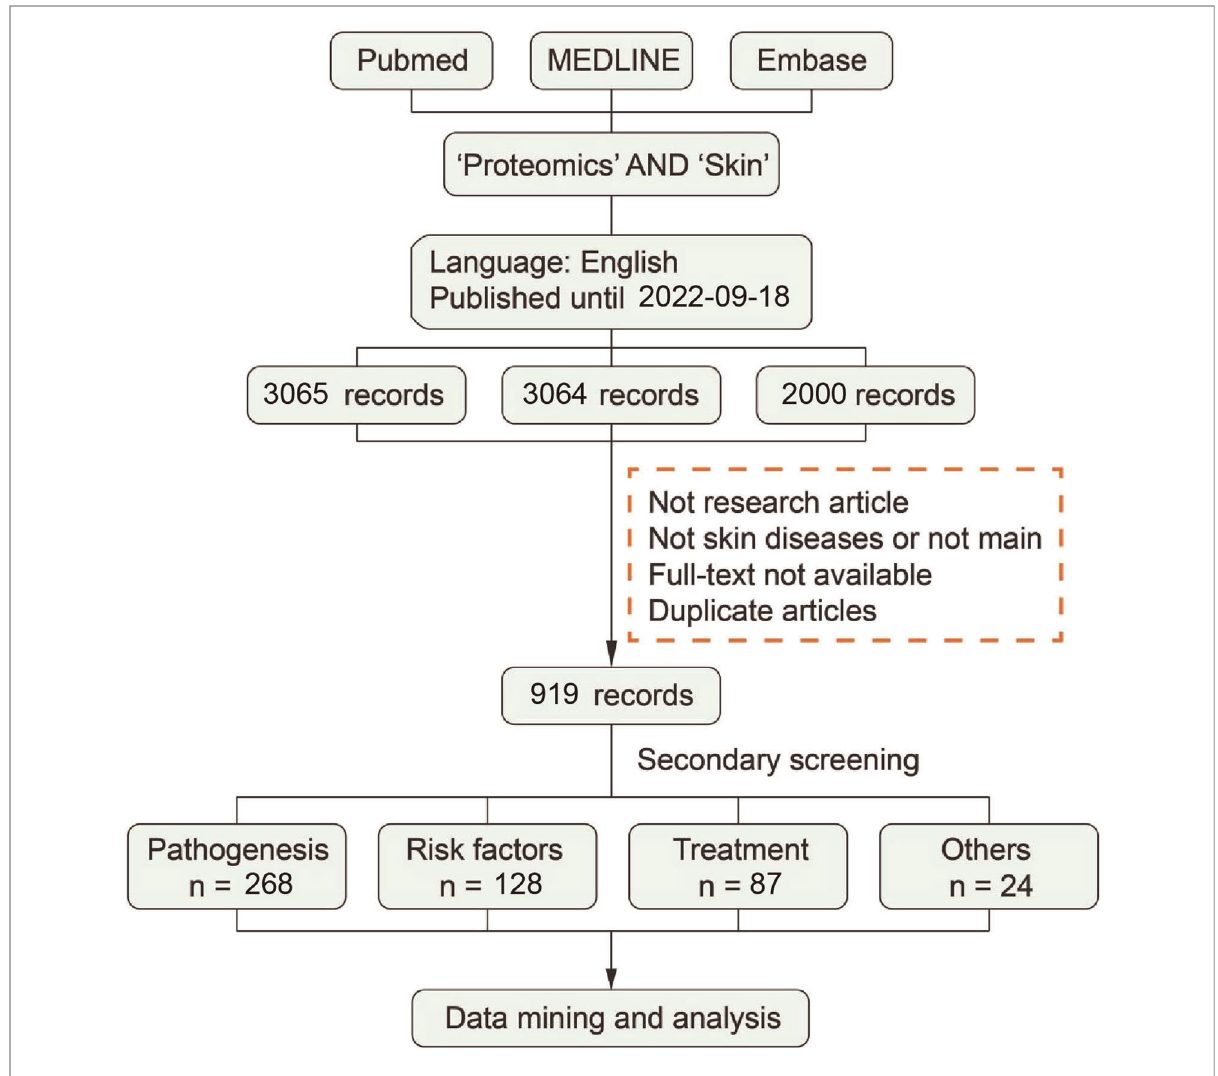
FIGURE 2 Systematic literature search and outcome identi fi